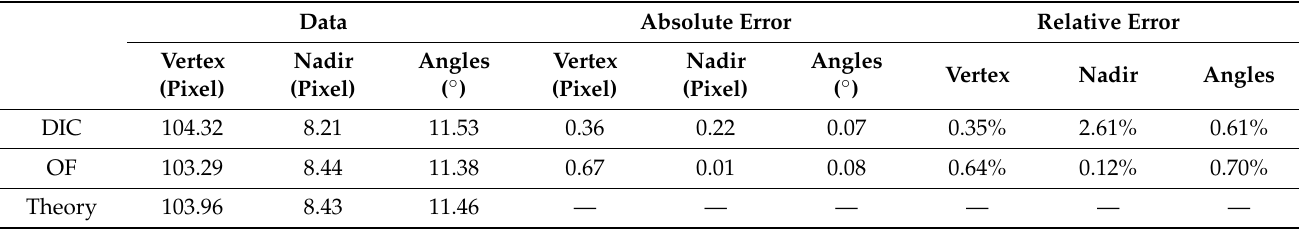
Table 1. Data of vertex and nadir in Figure